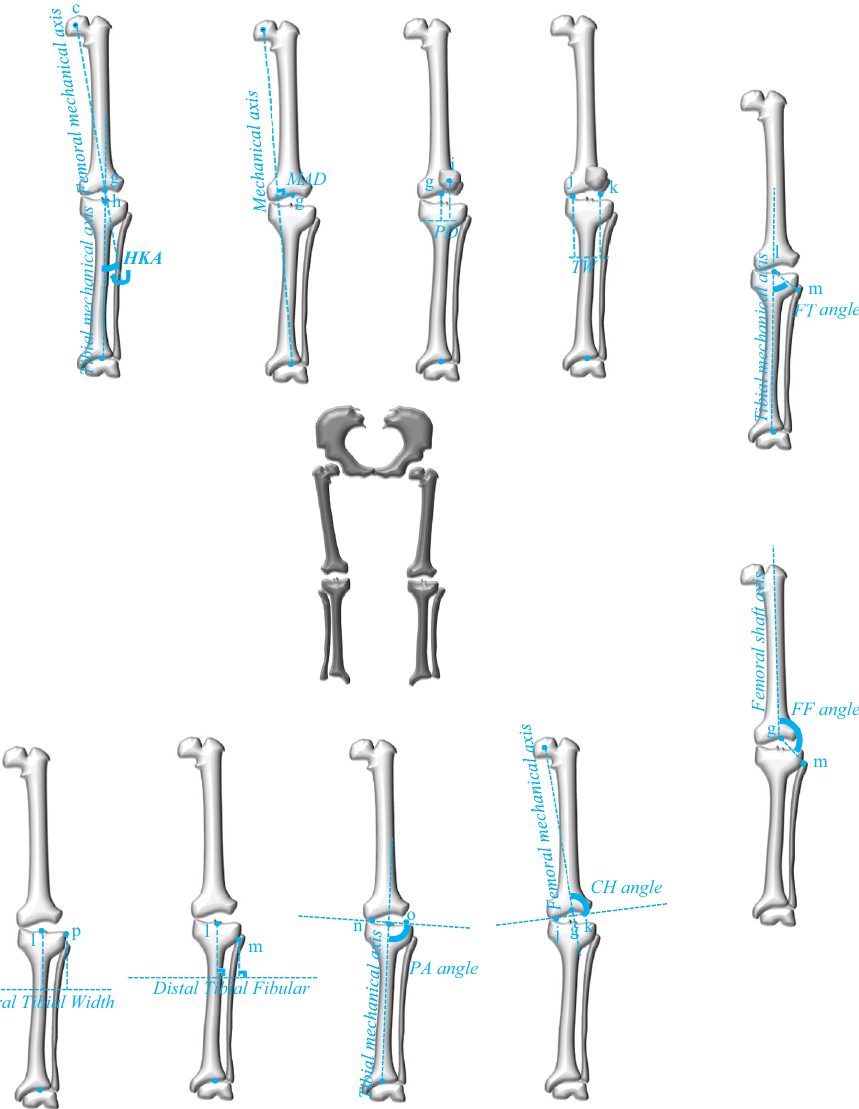
Figure 3. Morphometric parameters in the knee joint were measured on the anteroposterior view. HKA hip- knee-ankle angle, MAD mechanical axis deviation, PD patellar displacement, TW trochlear width, FT angle fibular-tibial angle, FF angle fibular-femoral angle, CH angle condylar-hip angle, PA angle tibial plateau-ankle angle.